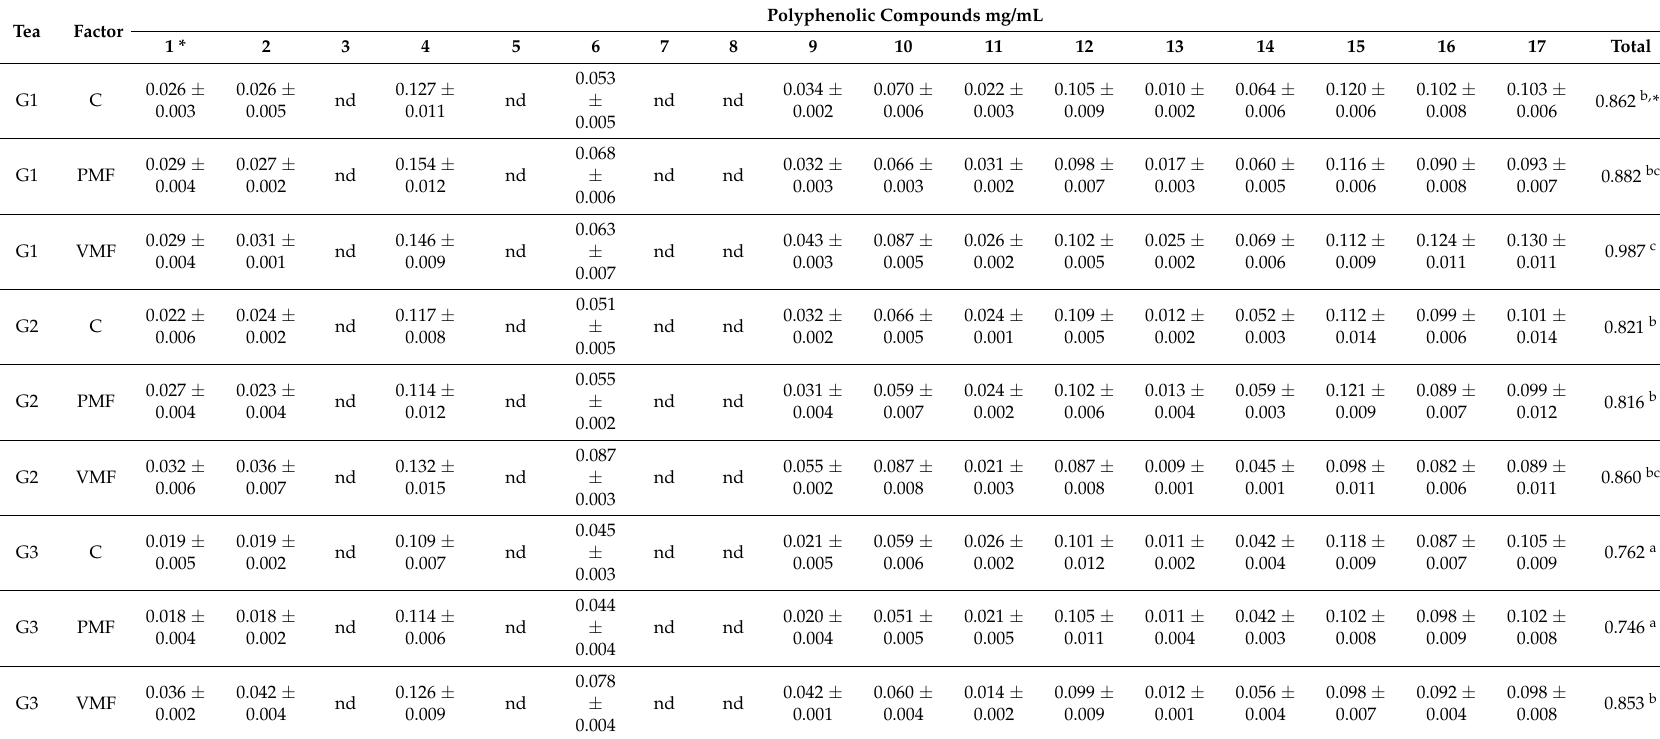
Table 6. Analytical findings showing contents of selected polyphenolic compounds in green tea infusions extracted with the use of a magnetic field under control